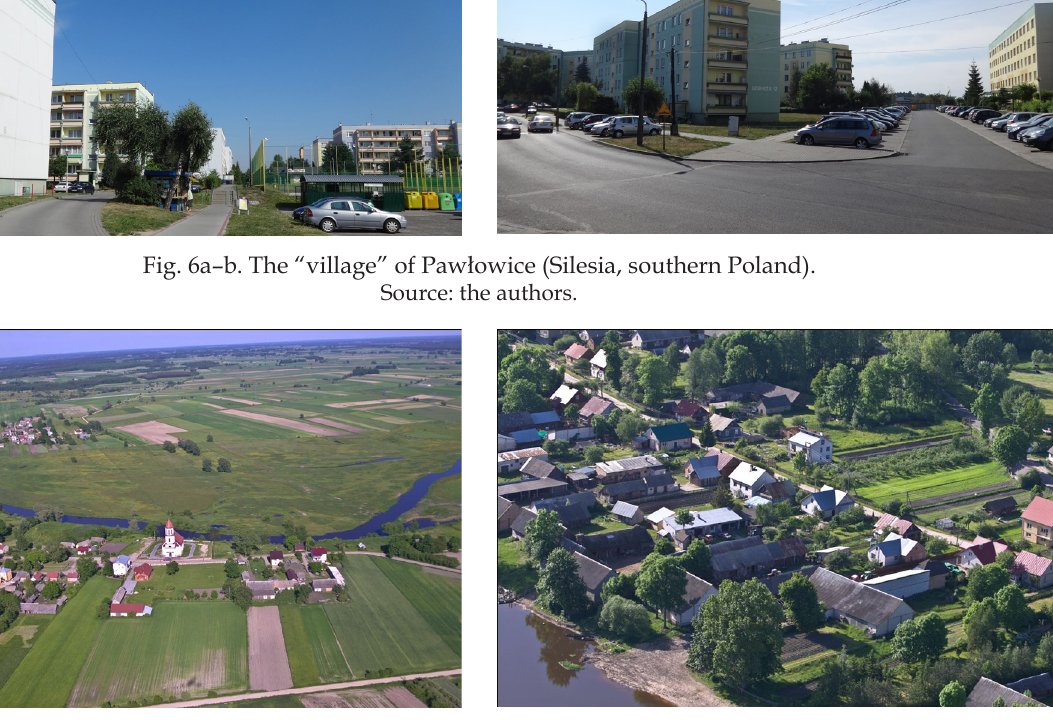
fig. 7a–b. The “city” of Suraż (north-eastern Poland). Source: photo gallery of the commune of